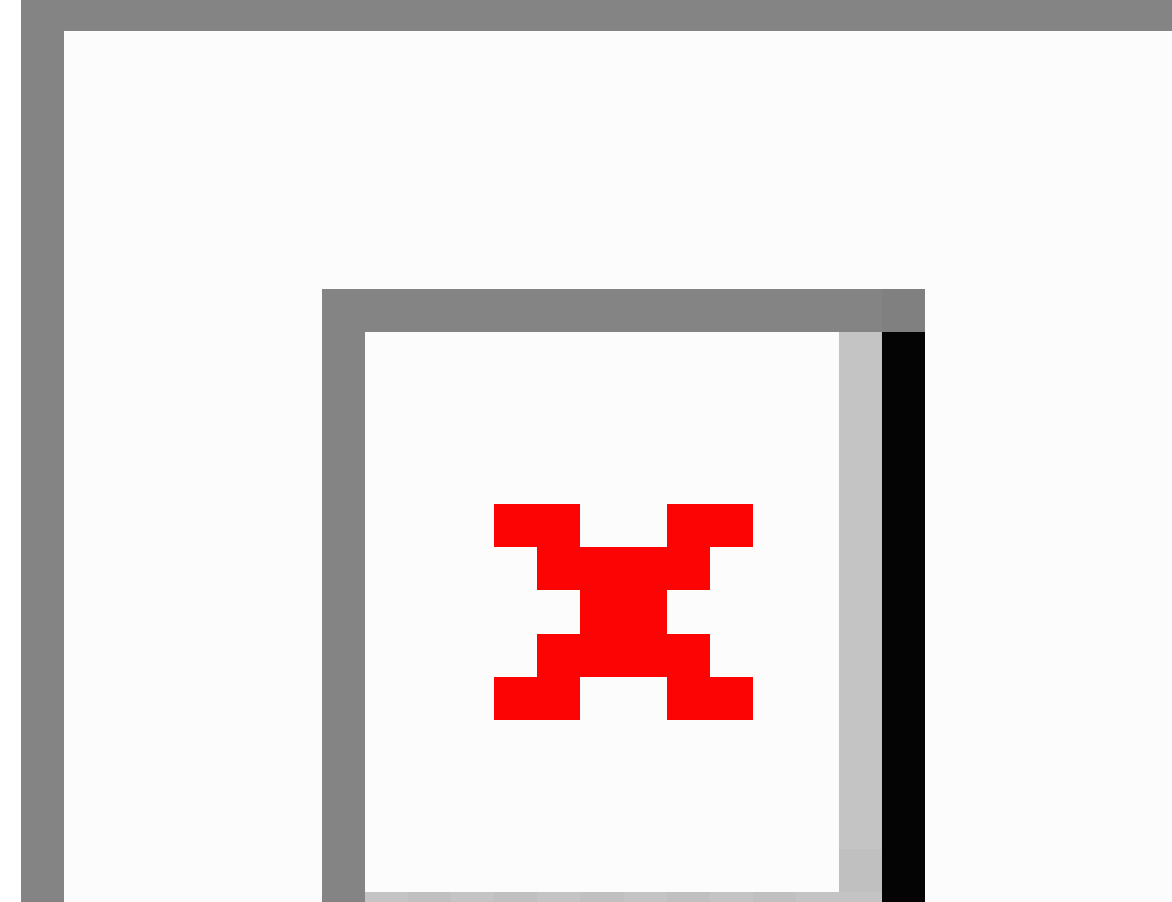
Figure 1. The “5S” levels of organization of evidence from health care research and the position of the studied information sources within the pyramid (after Haynes